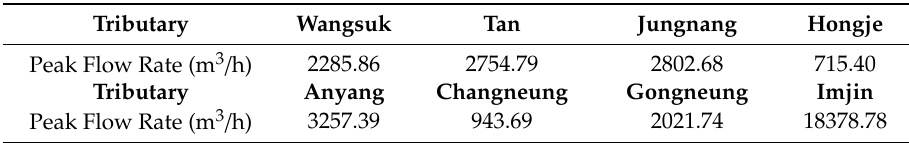
Table 1. Peak Flow Rate of Main